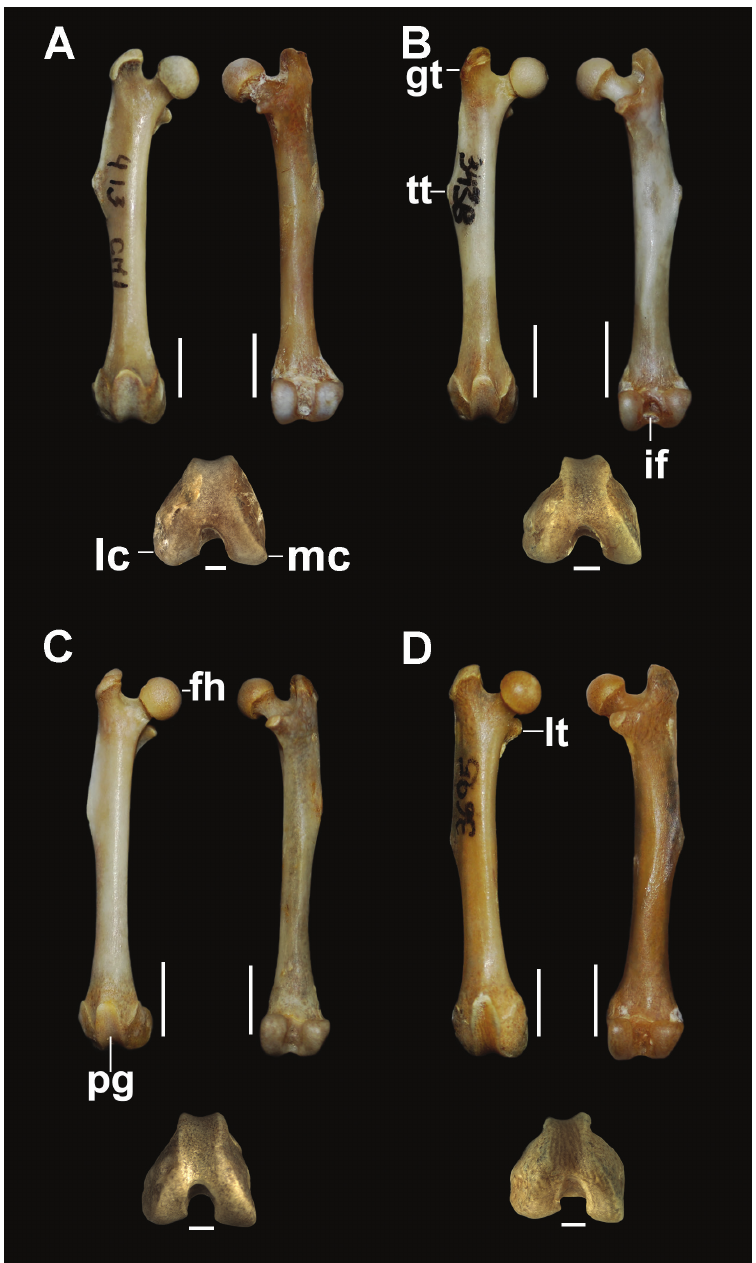
Figure 5. Right femur, anterior, posterior, and distal views. A Tympanoctomys aureus B Tympanocto- mys barrerae C Tympanoctomys kirchnerorum D Tympanoctomys loschalchalerosorum . fh, femoral head; gt, greater trochanter; if, intercondylar fossa; lc, lateral condyle; lt, lesser trochanter; mc, medial condyle; pg, patellar groove; tt, third trochanter. Scale bars 5 mm for all views except distal view where the scale bars are 1